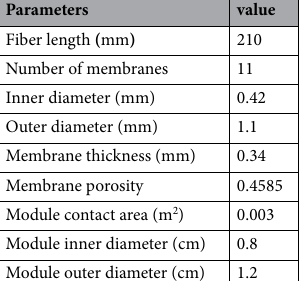
Table 2. Characteristics of PVDF hollow fiber member module used in this